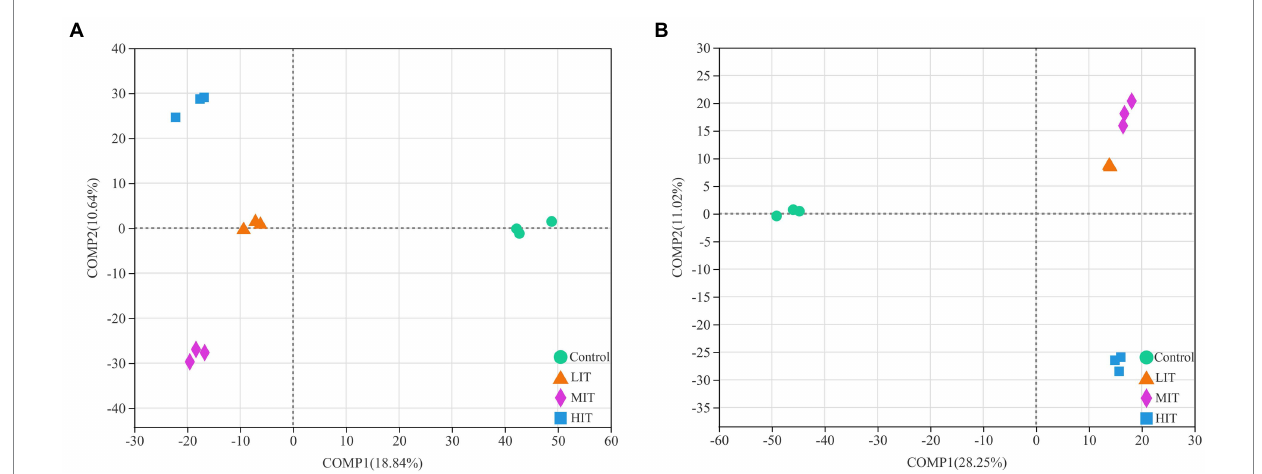
FIGURE 3 Partial least squares discriminant analysis (PLS-DA) of bacterial (A) and fungal (B) community composition among four thinning intensity treatment sites.